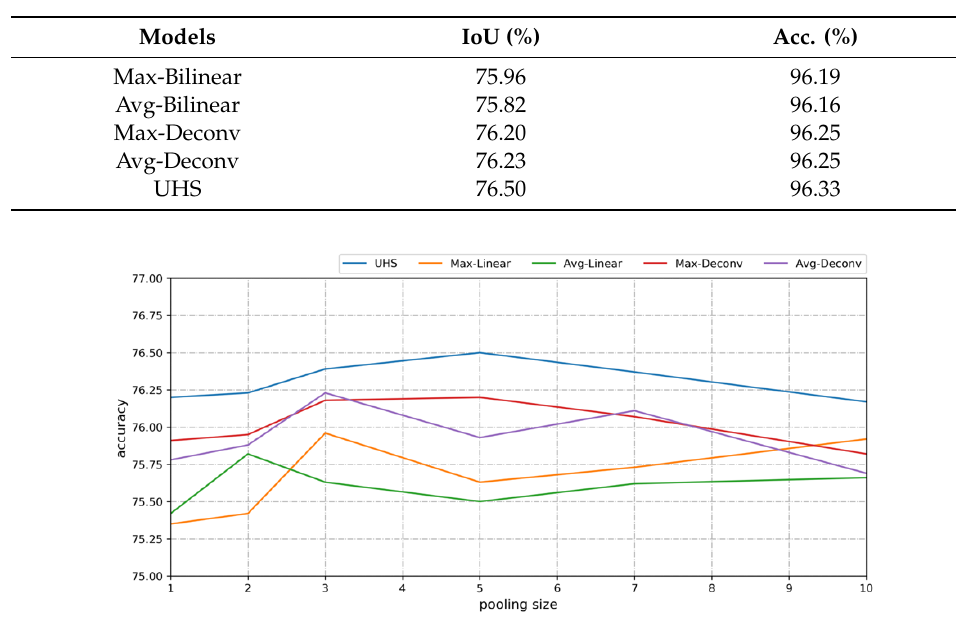
Figure 7. IoU line chart of Web-Net with the UHS block, Max-Linear, Avg-Linear, Max-Deconv, and Avg-Deconv operations.